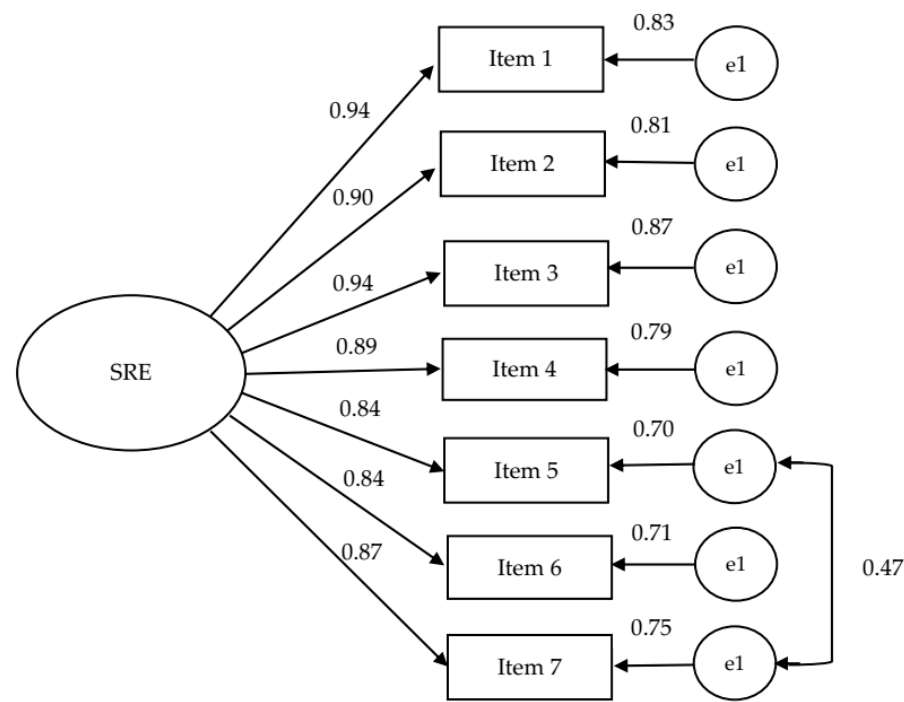
Figure 2. CFA of the sport-specific doping self-regulatory efficacy scale.